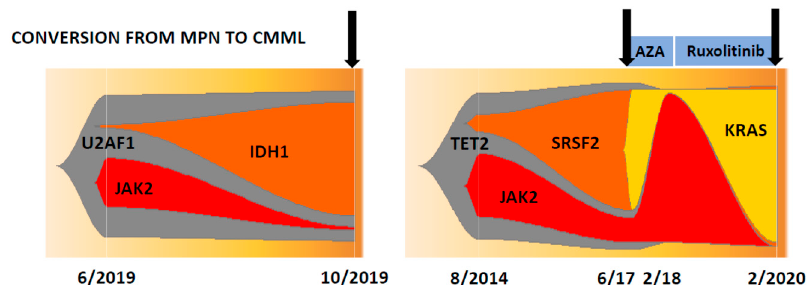
Figure 2. Clonal evolution in two patients with polycythemia vera who developed a CMML-like phenotype (indicated by arrows) during the course of their disease. The numbers indicate the month and year of NGS analysis.